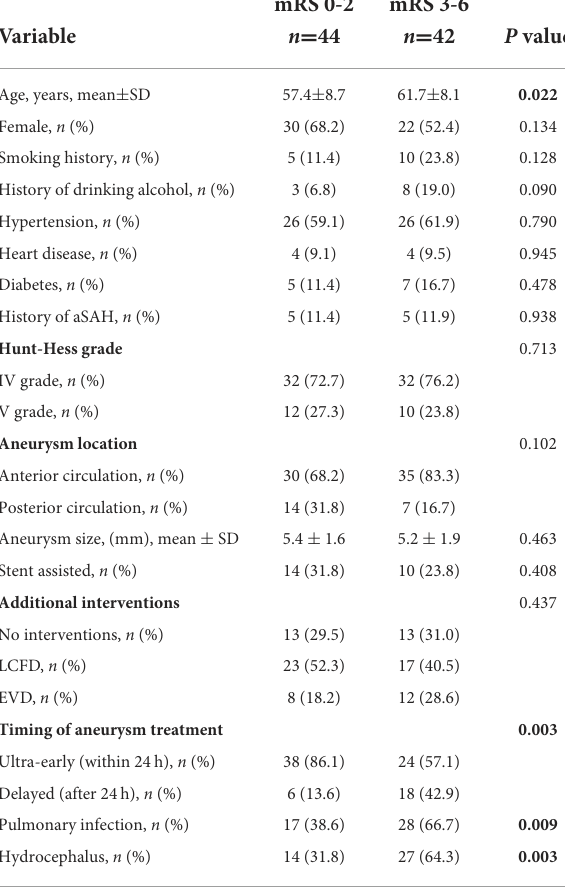
TABLE 3 Comparison of demographic, clinical, aneurysm, and treatment characteristics of patients with high-grade aSAH with ultra-early endovascular treatment vs. delayed endovascular treatment.